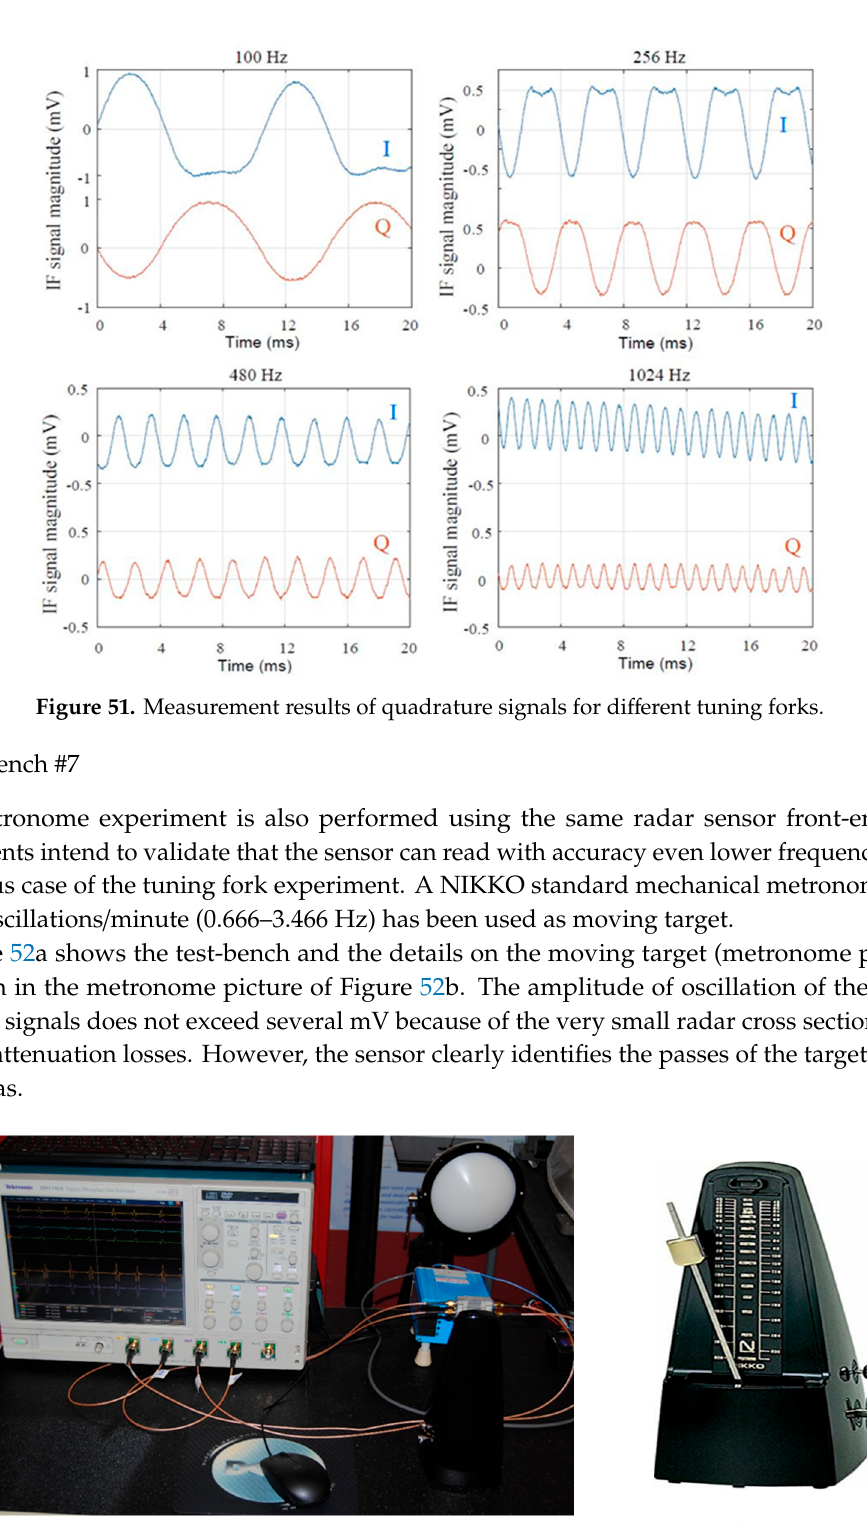
Figure 50. E-band radar sensor test-bench for tuning fork experiment.